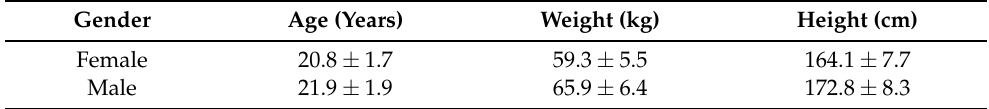
Table 1. Volunteer descriptive data (M ± SD).